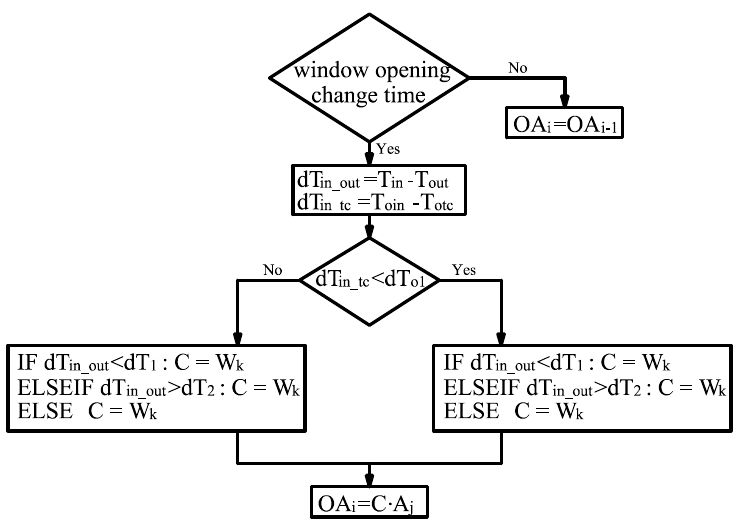
Figure 2. Controller operating diagram.